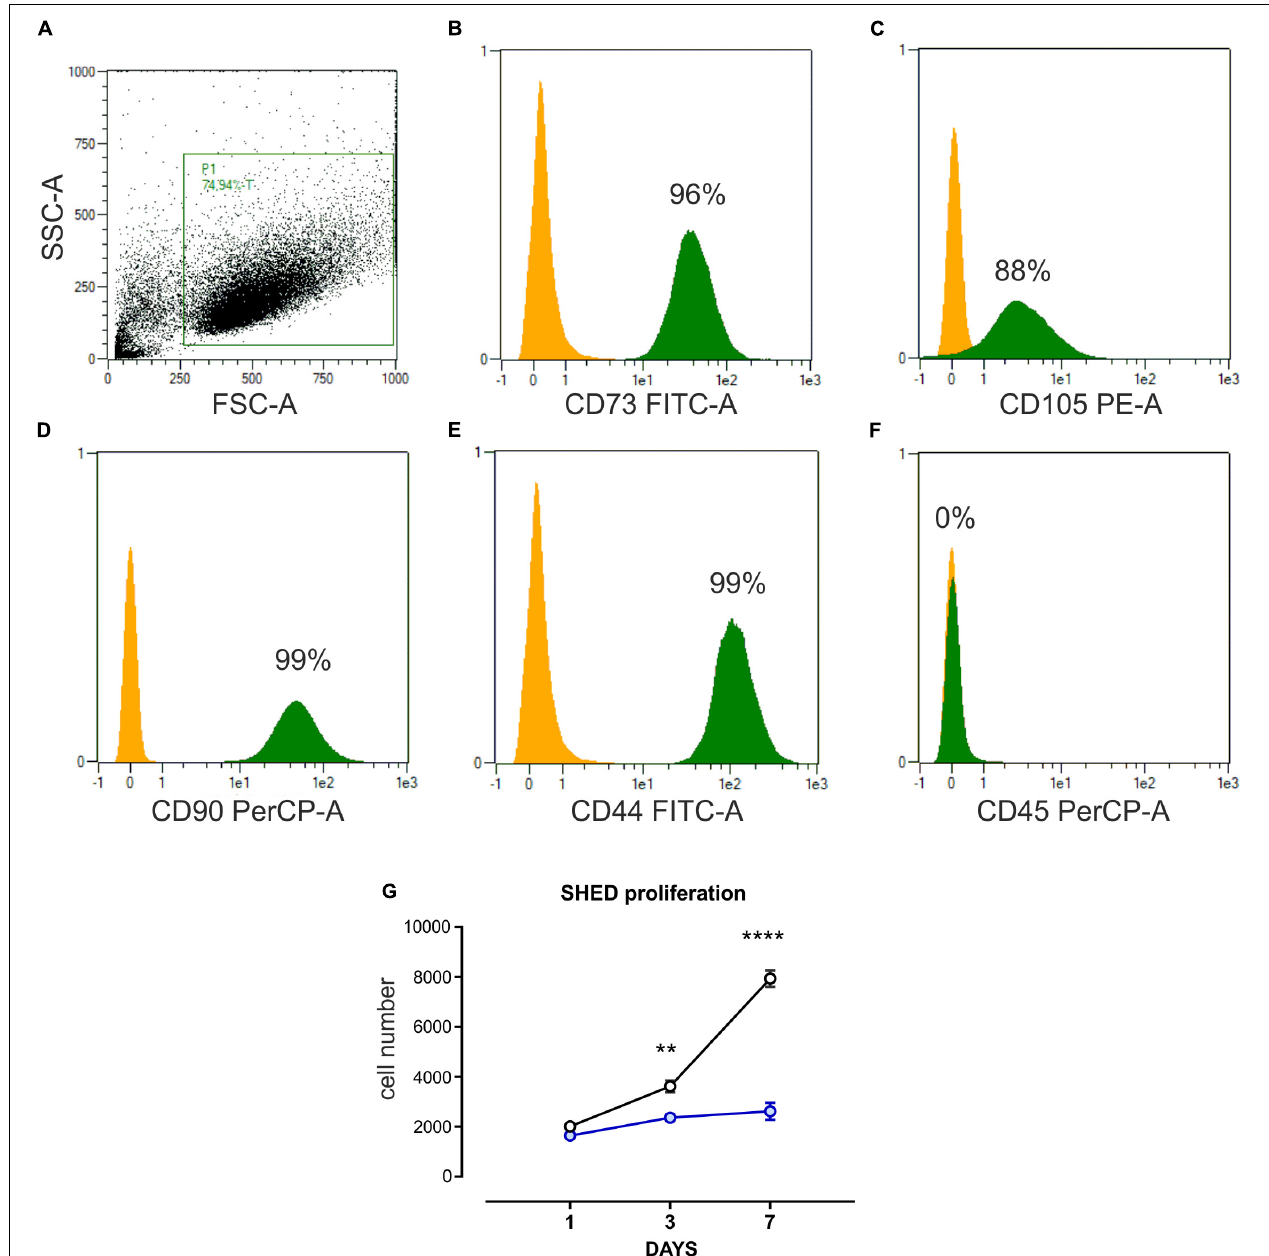
FIGURE 1 | Characterization of SHED. (A–F) Flow cytometer analysis performed on stem cells isolated from human exfoliated deciduous teeth (SHED) and cultured in vitro. Undifferentiated SHED showed the typical mesenchymal phenotype, expressing CD73, CD105, CD90, CD44, and negative for CD45. P1 is the gate on mesenchymal stem cell (MSC) population, obtained after two in vitro passages. The yellow histogram represents the negative control, while the green one is the percentage of cells expressing the marker in P1, the MSC gate. (G) Cell count (DAPI staining) proliferation assay performed on SHED cultured in basal growth medium (black line) and osteo-differentiating medium (blue line), respectively. Data are expressed as mean ± SEM of n = 6; 2-way ANOVA with Bonferroni’s multiple comparison test was performed: ** p < 0.001; **** p <